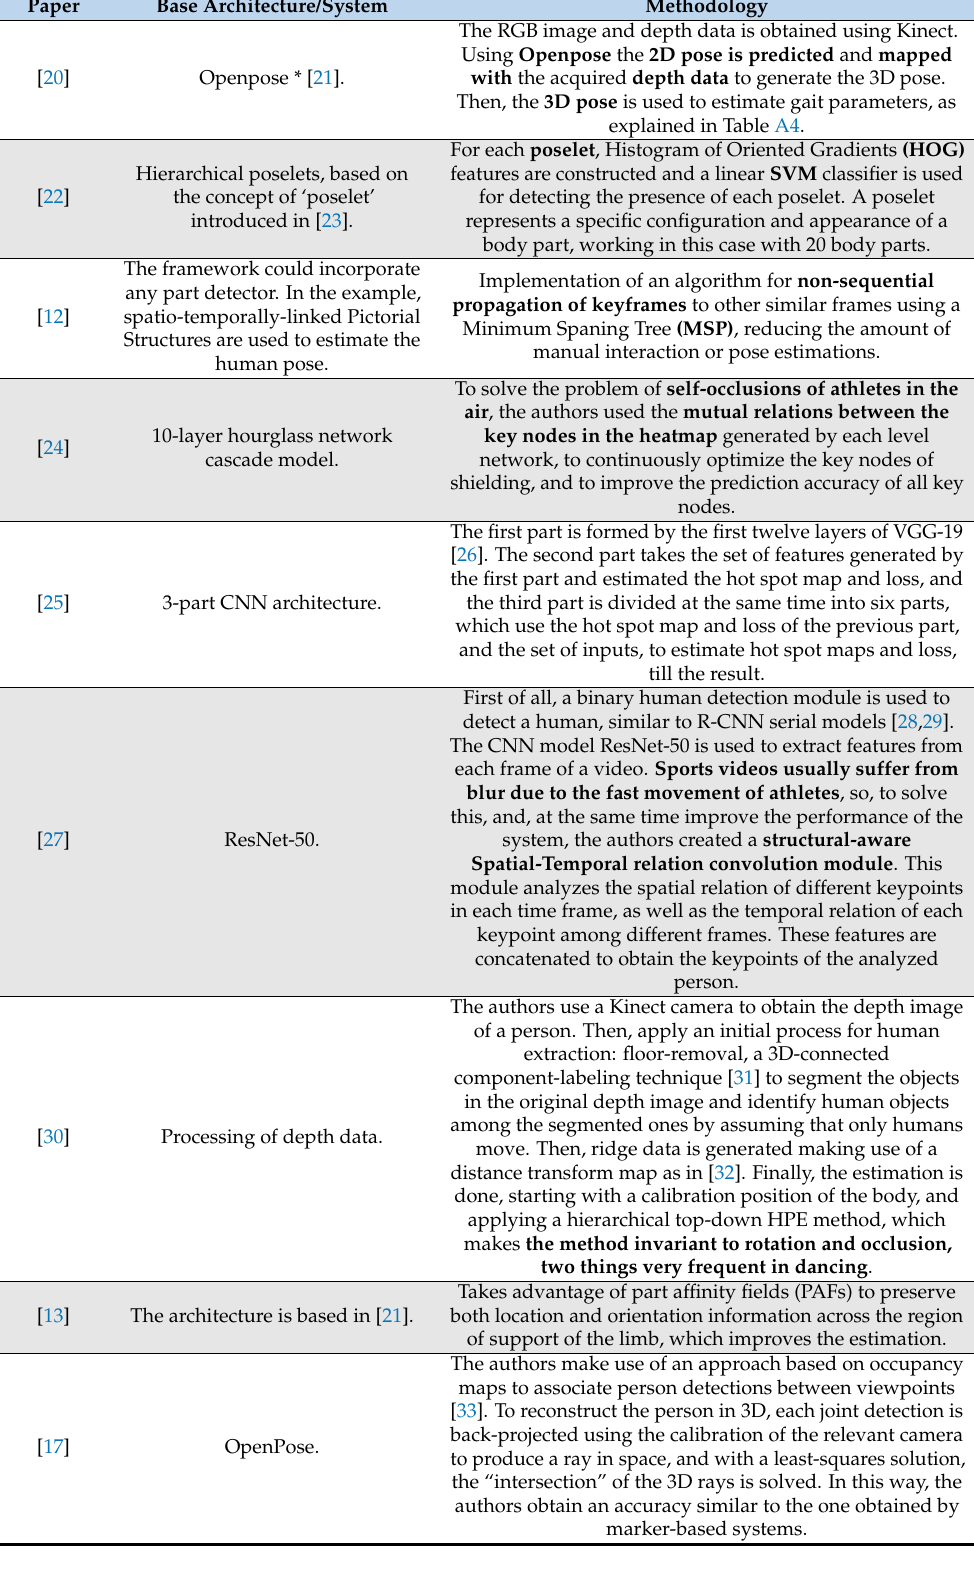
Table 4. Summary table of the technical implementation aspects of HPE of the filtered papers. * more details are provided in the following paragraphs